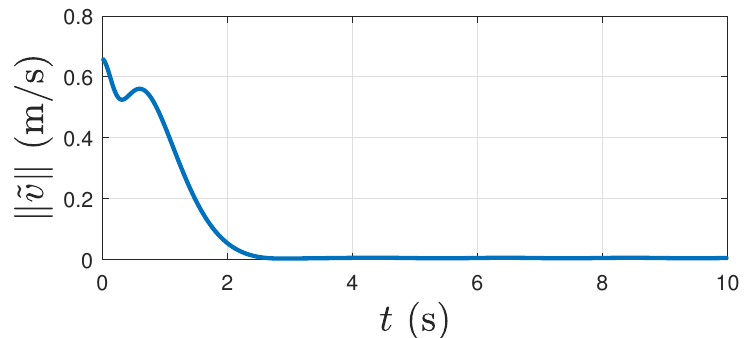
Figure 5. Magnitude of velocity error versus